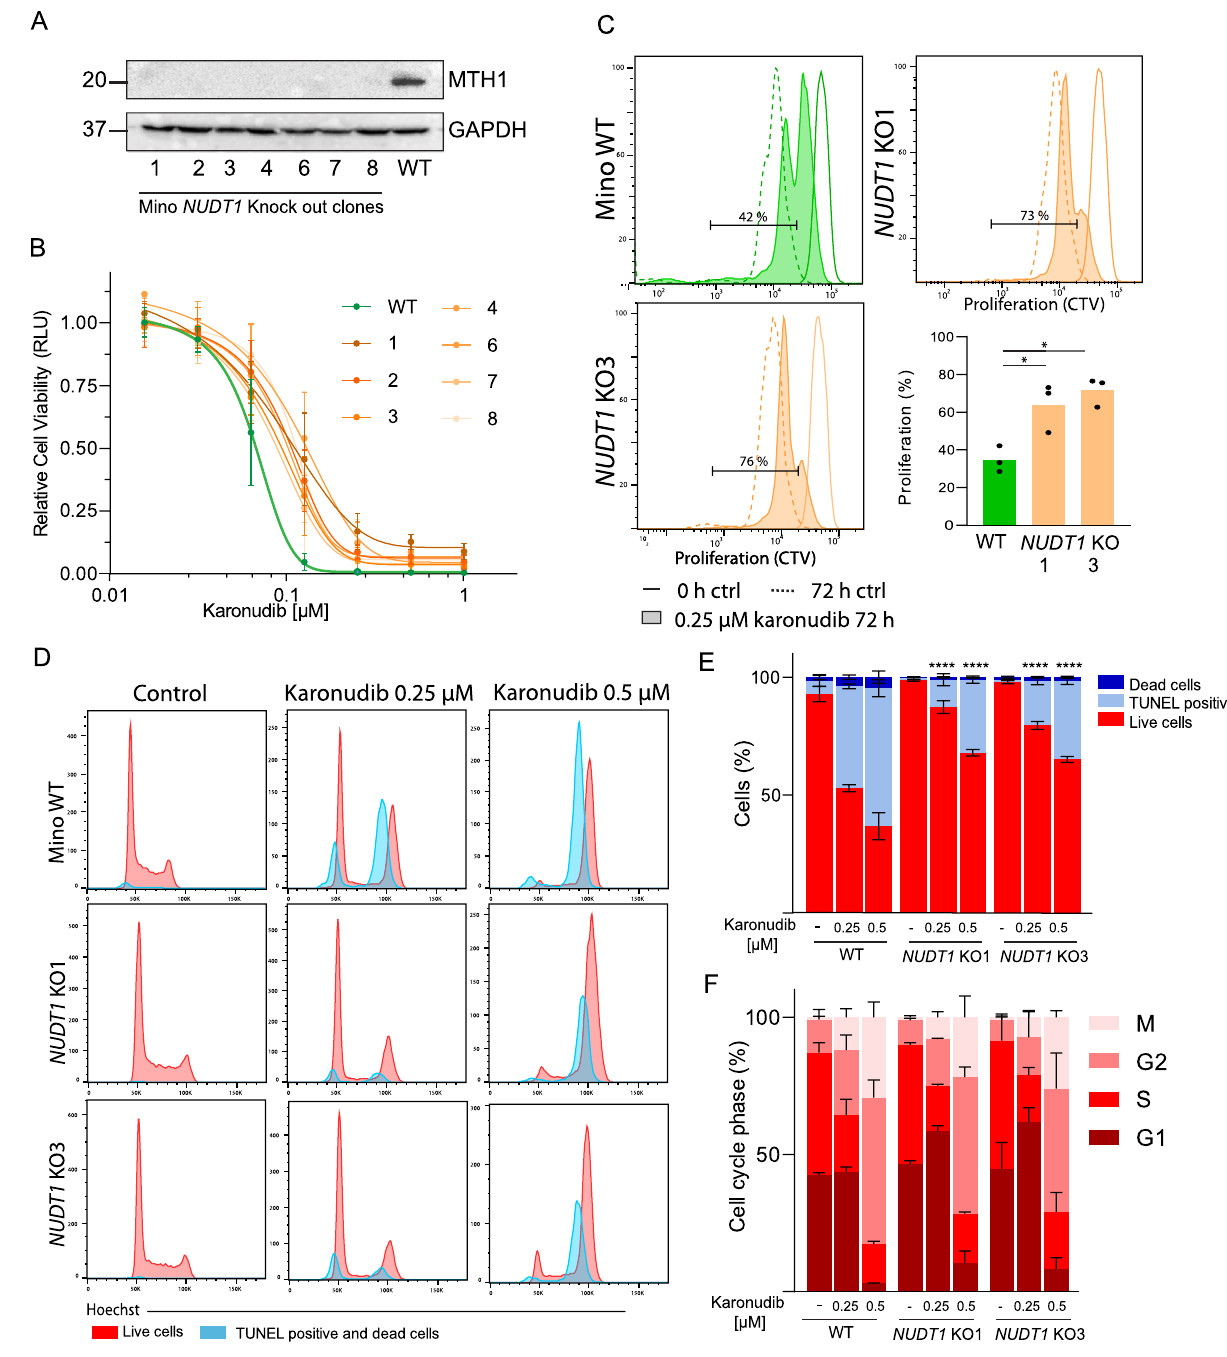
Figure 4. NUDT1 KO in Mino cell lines confirm dual mechanism of karonudib. Two NUDT1 KO clones of Mino were used to assess the effect of MTH1 loss in the lymphoma model. ( A ) Western immunoblot of seven clones show loss of MTH1 expression. ( B ) Cell viability was measured in Mino WT (green) and NUDT1 KO (orange) by CellTiterGlo and normalized to untreated samples (karonudib, 0.0125–1 µM, 72 h, n = 3) ( C ) Proliferation using Cell Trace Violet (CTV) is shown for Mino WT, NUDT1 KO1 and NUDT1 KO3 (continuous line: control cells at time zero, dashed line: control 72 h and filled histogram: 0.25 µM karonudib 72 h). Quantification of the % (shown in gate) of proliferating cells in WT and 0.25 µM karonudib treated cells. *Significant differences ( P < 0.05), repeated measurements one-way ANOVA with Dunetts correction between WT and the KO-clones. ( D ) Gating strategy to identify live, dead and apoptotic cells is shown for Mino cells in Fig. 2B. Histogram representing live (red) and dead/apoptotic cells (blue) show G 2 accumulation and M-arrest after karonudib treatment, 24 h. ( E ) TUNEL + , light blue,; dead cells, dark blue,; and live cells in red show the frequencies of these populations in Mino WT, NUDT1 KO 1 and NUDT1 KO 3 (karonudib, 0.25 and 0.5 µM, 24 h, n = 3). *Significant differences ( P < 0.0001, one-way ANOVA with Dunetts correction) between WT and the KO-clones for both concentrations of karonudib. ( F ) Cell cycle analyses of the live cells from ( E